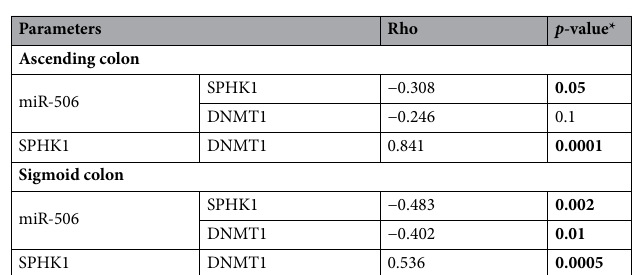
Table 1. Spearman’s rank correlations for miR-506, SPHK1, and DNMT1 mRNA expressions analyzed in colon tissue of PSC (n = 10), PSC + UC (n = 10), and UC (n = 10) patients. miR-506 microRNA-506, SPHK1 sphingosine-kinase-1, DNMT1 DNA-methyltransferase-1, mRNA messenger RNA. *Value in boldface indicates statistically significant difference (Spearman’s rank